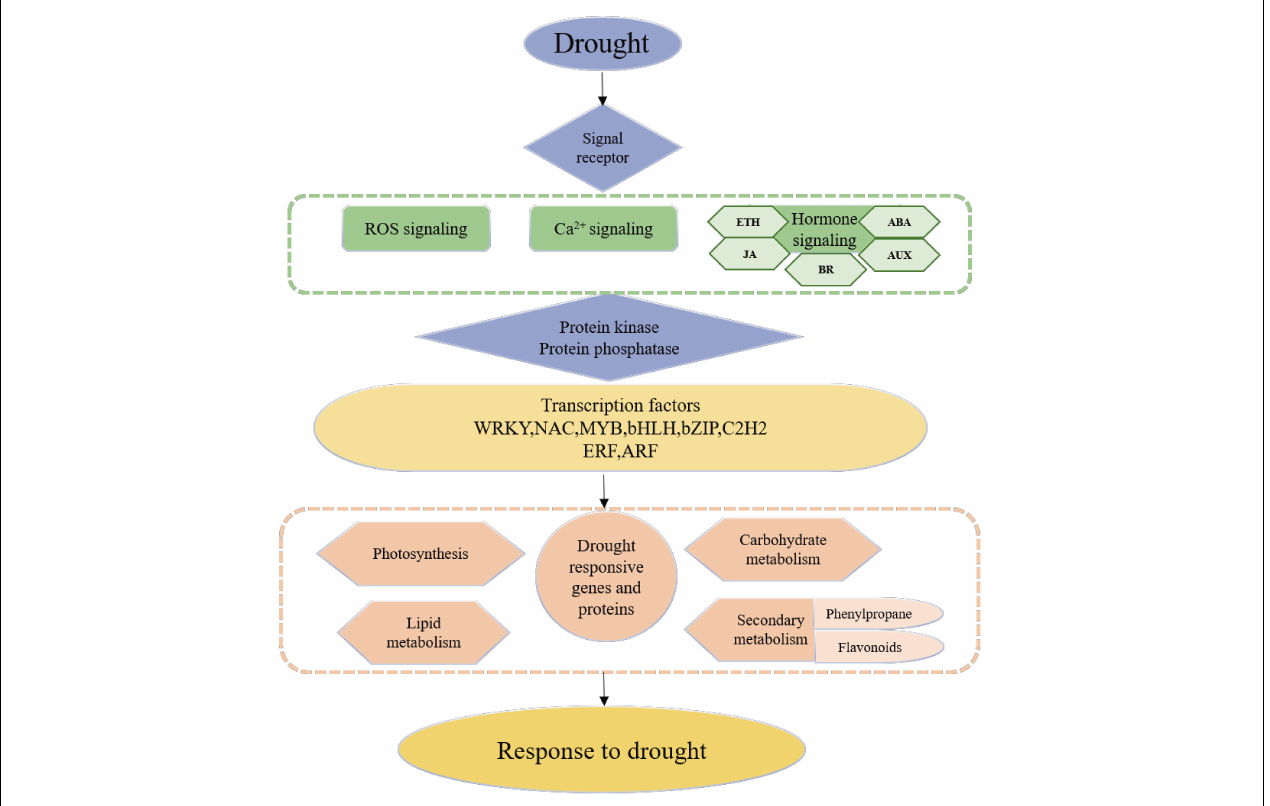
FIGURE 10 | The hypothetical model of Rosa chinensis ‘Old Blush’ in response to drought